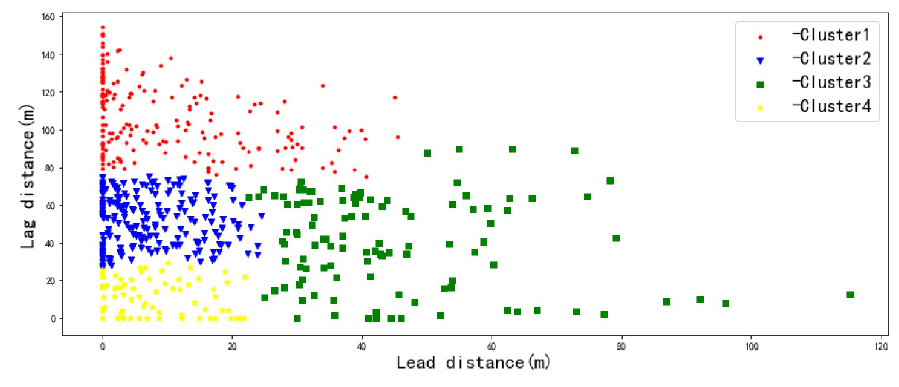
Fig 9. Hierarchical clustering analysis results.